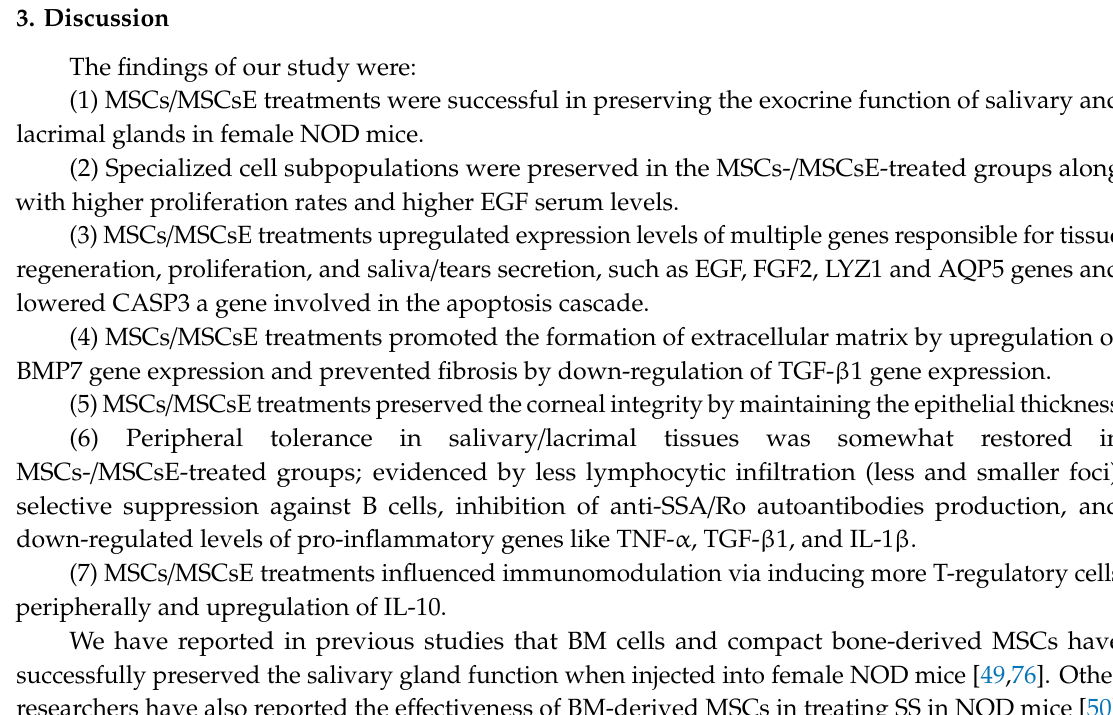
Figure 6. Serum levels of anti-SSA / Ro autoantibodies and IL-10, and gene expression levels of anti- / pro-inflammatory cytokines / factors at 16 weeks post-treatment. ( A ) Serum levels of anti-SSA / Ro autoantibodies (assessed by ELISA) for MSCs- / MSCsE-treated groups exhibited significantly lower levels in comparison to the control group. ( B ) Serum levels of IL-10 (assessed by ELISA) for MSCs- / MSCsE-treated groups were significantly higher than the control group. ( C ) Gene expression levels for anti- / pro-inflammatory cytokines / factors were measured using quantitative RT-PCR in the submandibular and lacrimal glands. MSCs / MSCsE treatments upregulated IL-10 and down-regulated TNF- α gene expressions in both glands, and down-regulated TGF- β , IL-1 β in lacrimal glands. Y-axis shows the relative expression of the gene compared to GAPDH, three experimental replicates were conducted for each sample. * p < 0.05; ** p < 0.01; *** p < 0.001; **** p ≤ 0.0001, n = 4–6. All data were presented as mean ± S.D. Control: saline-treated; MSCs: Mesenchymal stem cells; MSCsE: Mesenchymal stem cells